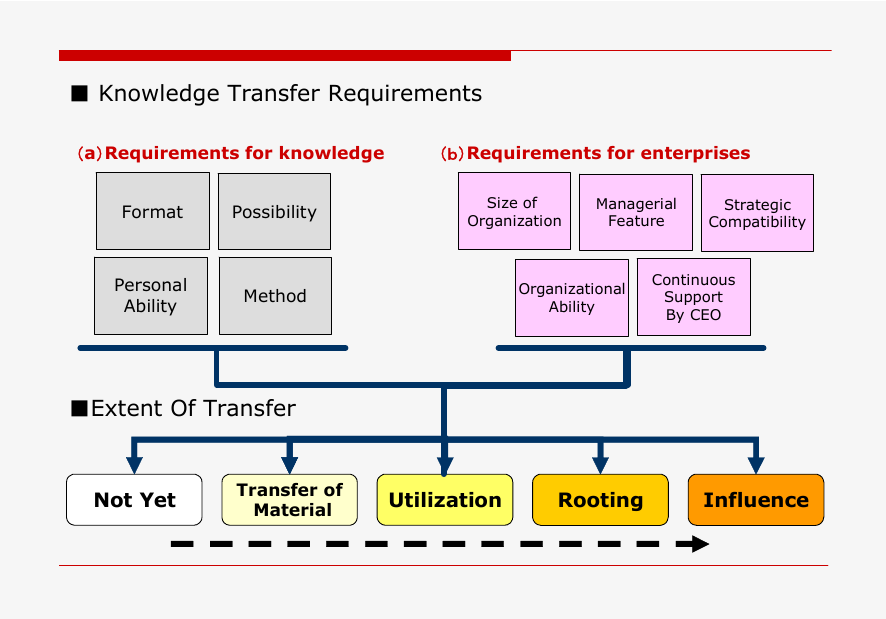
Figure 5. Requirements for knowledge transfer and extent of